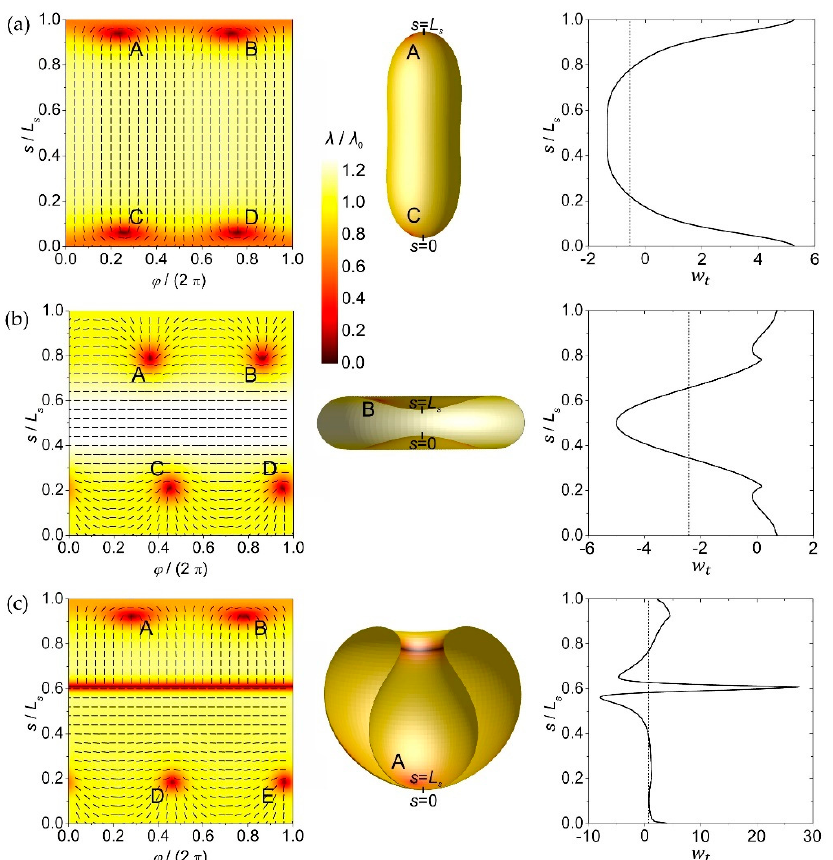
Figure 5. Extrinsic curvature dominated order parameter profiles, equilibrium membrane shapes and the corresponding w t ( s ) profiles for ( a ) prolates, ( b ) oblates and ( c ) stomatocytes. The nematic director field is superimposed onto the order parameter profile λ / λ 0 in the ( ϕ , s )-plane. The function w t ( s ) was calculated for λ 0 = 1/2. Positions of TDs are denoted with capital letters. L s stands for the length of the profile curve. Parameters: ( a ) v = 0.80, ( b ) v = 0.60, ( c ) v = 0.45; R / ξ = 7, k e = k i /2, k i = к